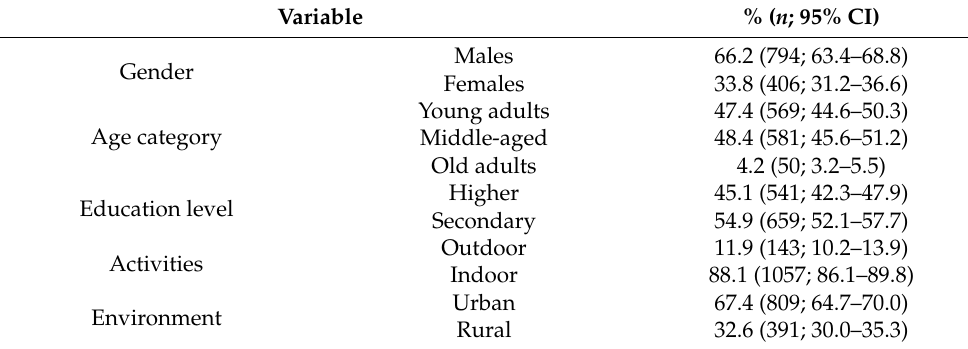
Table 1. Group characteristics concerning